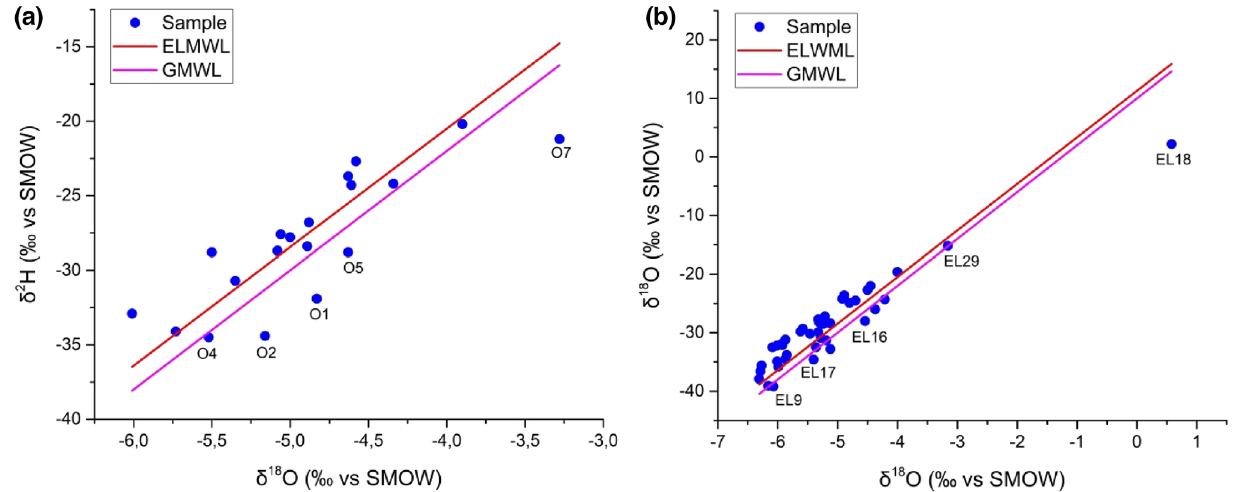
Fig. 9 Plot of δ 2 H vs δ 18 O for the groundwater for the campaign 2016a and the campaign